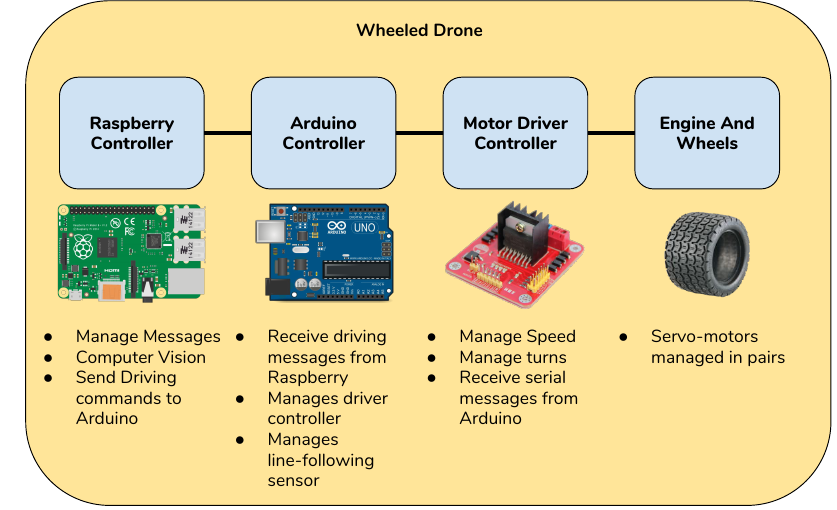
Figure 4. Unmanned ground vehicle (UGV) boards components and logic